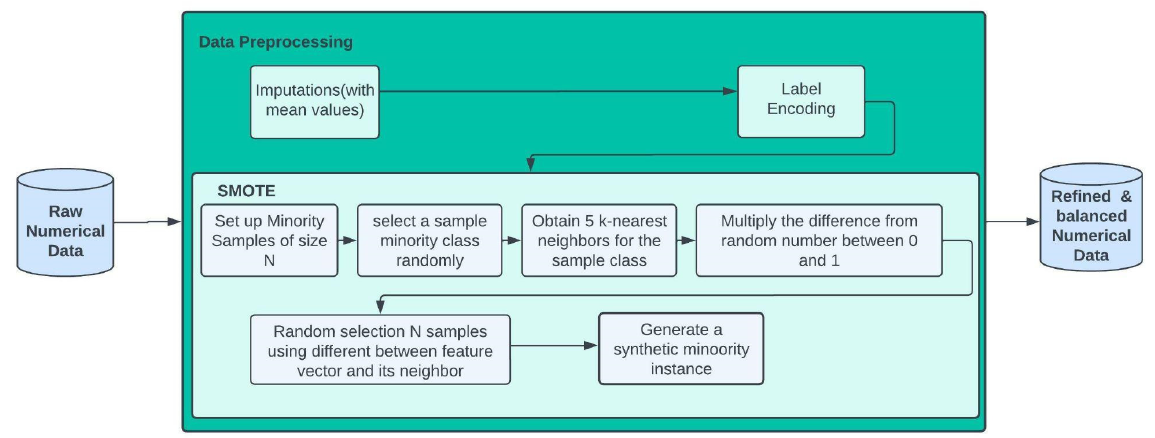
Figure 3. Data preprocessing steps applied to the numerical dataset.